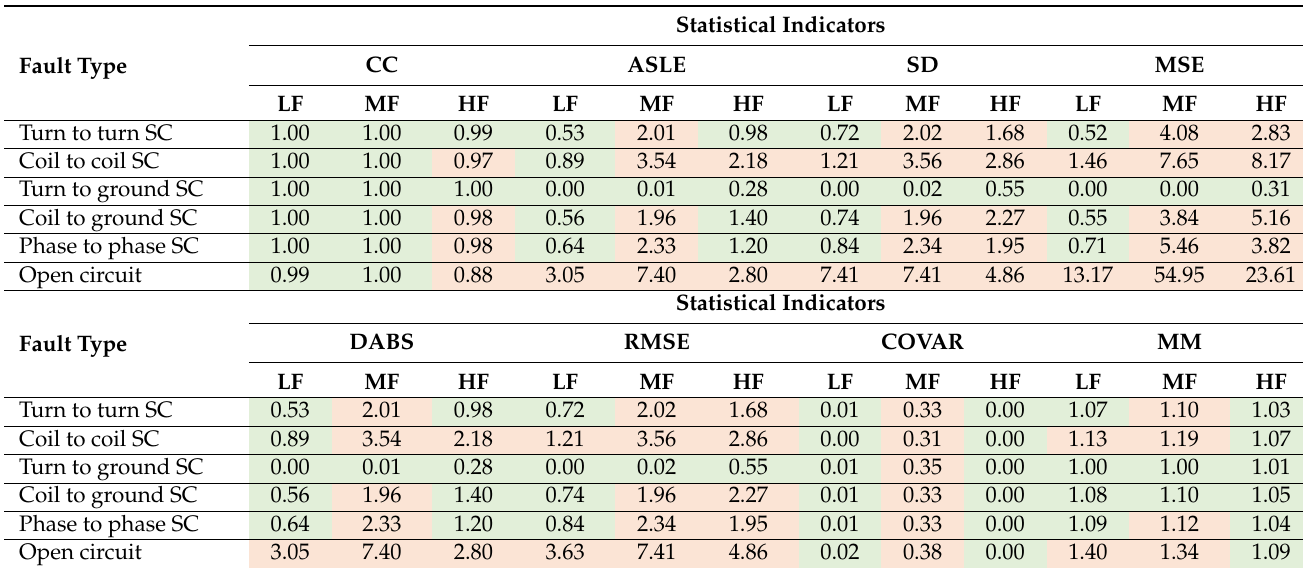
Table 9. Statistical indicators for normal and faulty FRA signatures of the tested IM with delta stator